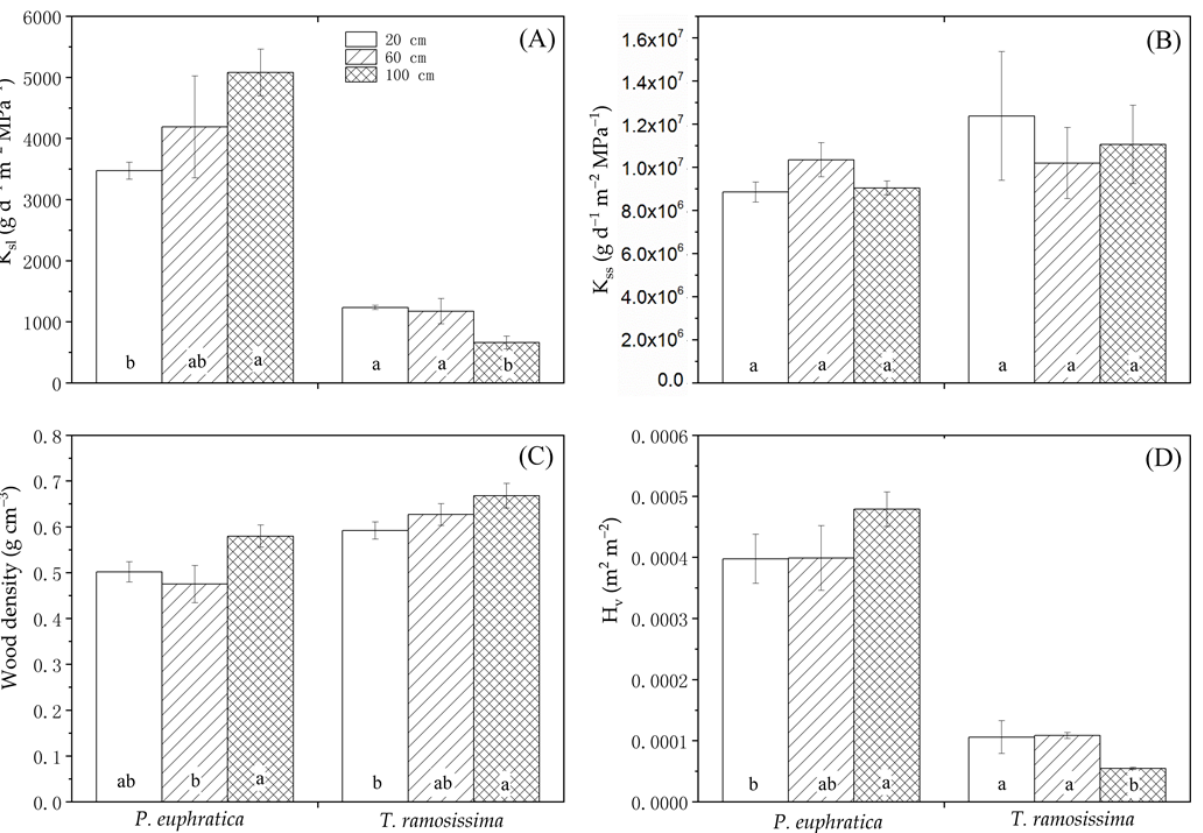
Figure 5. Whole-plant leaf area-specific hydraulic conductance ( A ), sapwood-area hydraulic conductance ( B ), wood densities ( C ), and Huber values ( D ) for Populus euphratica and Tamarix ramosissima seedlings grown 20 cm, 60 cm, and 100 cm from the groundwater level. Values are mean ± SE. Letters indicate significant differences among treatments for each species as determined by ANOVA ( p < 0.05).